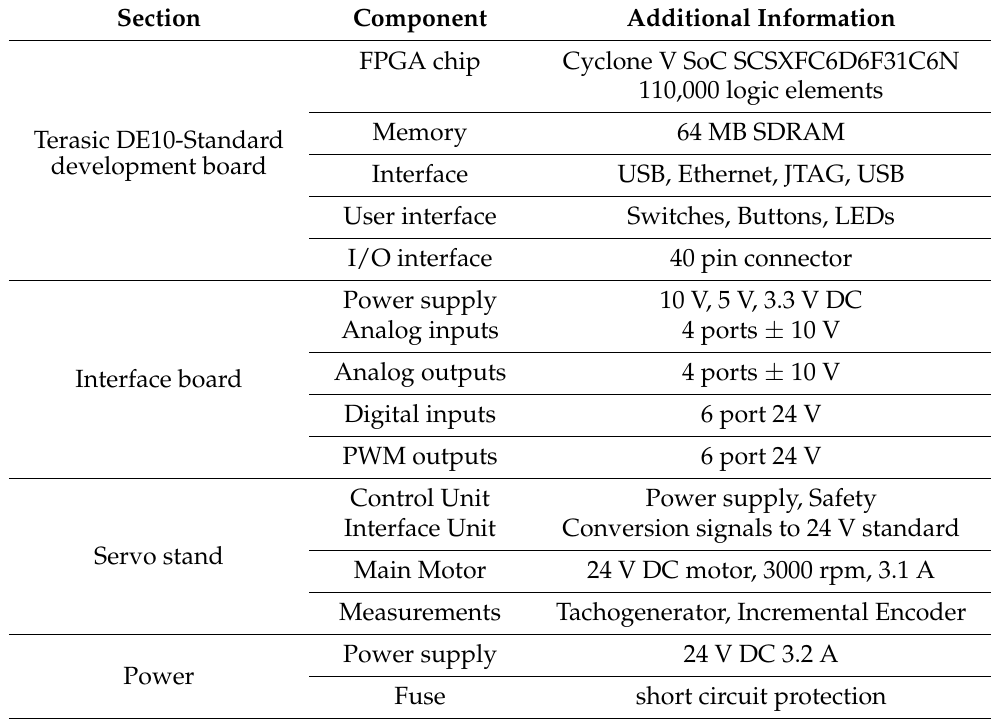
connected with a modular servomotor. This servomotor is made by Inteco and allows the use of a PWM signal to influence the rotational speed of the servo. As the measurements, readings from the tachogenerator are used. As the power cannot be given from the de- Table 1. Servomotor’s speed is controlled with an FDMC controller with an intervention period of 0.01 s. Table 1. Test enviroment equipment